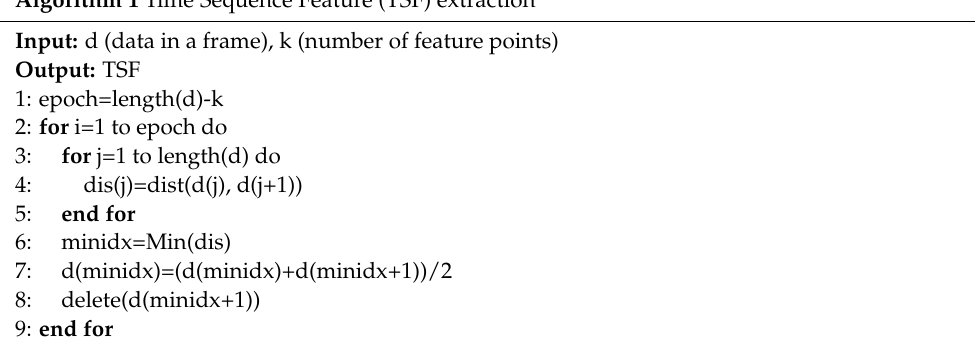
Algorithm 1 Time Sequence Feature (TSF)